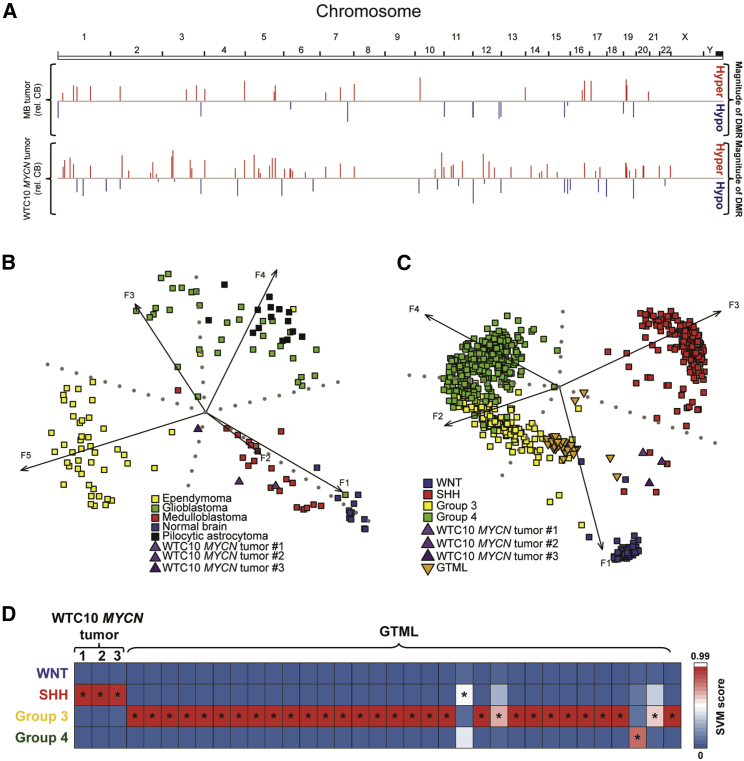
WTC10 MYCN Tumors Align with SHH Medulloblastoma(A) Genomic DNA was extracted from WTC10 MYCN tumors and analyzed via Illumina methylation arrays. Differentially methylated regions (DMRs) relative to normal human cerebellum were identified in SHH medulloblastoma (MB) from patients with MYCN-amplified tumors (top) and compared with WTC10 MYCN tumors (bottom). The complexity of overall methylation differences (comparing normal cerebellum with each tumor type) was similar in WTC10 MYCN tumors and human medulloblastoma tumors, contrasting a published report comparing GEMM models (including MYCN-driven GEMMs) with human tumors (Diede et al., 2013).(B) Comparing transcriptomes of WTC10 MYCN tumors with other pediatric brain tumors using principal component analysis (PCA) showed WTC10 MYCN tumors aligned best with medulloblastoma.(C and D) Comparison of transcriptomes of human WTC10 MYCN tumors and murine MYCN-driven GEMM tumors (GTML, Swartling et al., 2010) with four major subgroups of medulloblastoma using (C) PCA and (D) support vector machine (SVM) classification. WTC10 MYCN tumors aligned with SHH subgroup, whereas GTML aligned with group 3 medulloblastoma. For SVM, colors indicate class prediction probabilities (blue, low; red, high), and asterisks denote the predicted class.See also Figures S2 and S7 and Tables S1, S4, and S6.